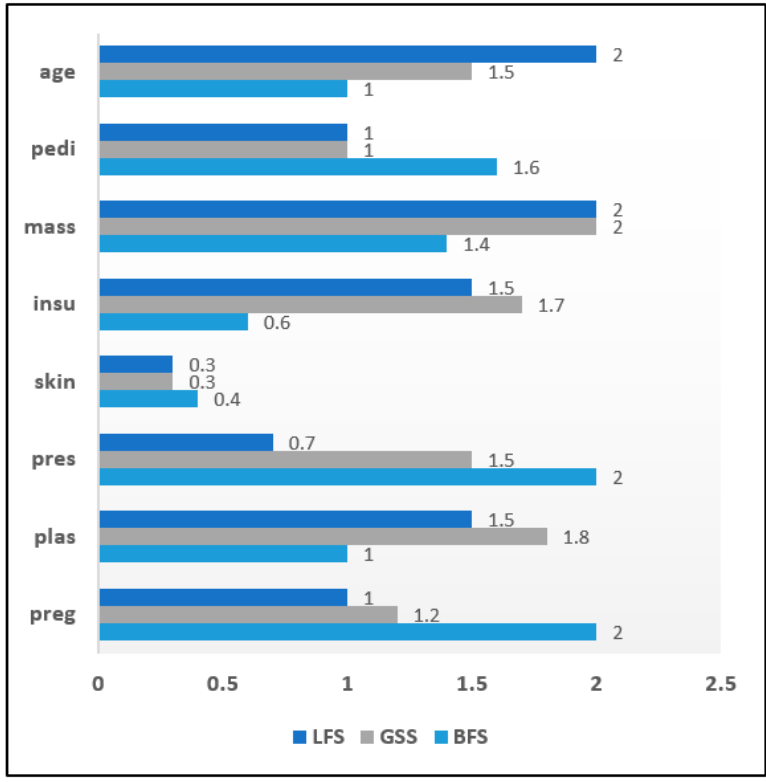
Figure 9. Attribute Significance Graph for the Heart disease dataset with Wrappers.